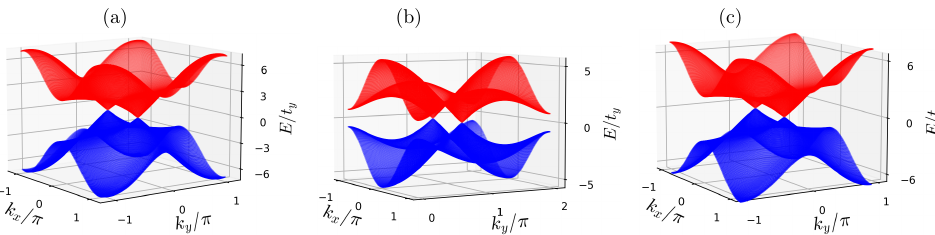
Figure 11: Energy spectrum of the zero field model showing Weyl nodes with linear dispersion along all directions near zero energy. (a) There are two Weyl nodes in the W2 phase which appear in the k phase: two of them occur in the (b) k plane